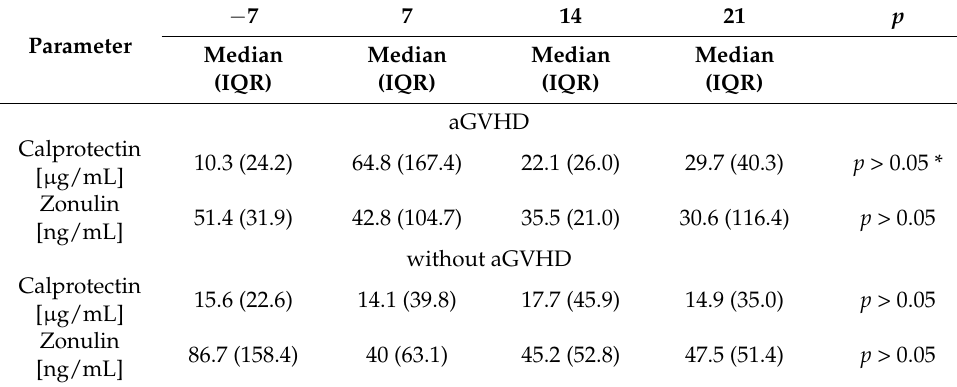
Table 3. Calprotectin and zonulin stool concentrations before the conditioning and in the post- transplant period in patients with and without aGVHD, * p < 0.05 between − 7 and +7. Normal values for zonulin is <30 ng/mL and for calprotectin it is <50 µ g/mL. A p -value less than 0.05 is considered to be statistically